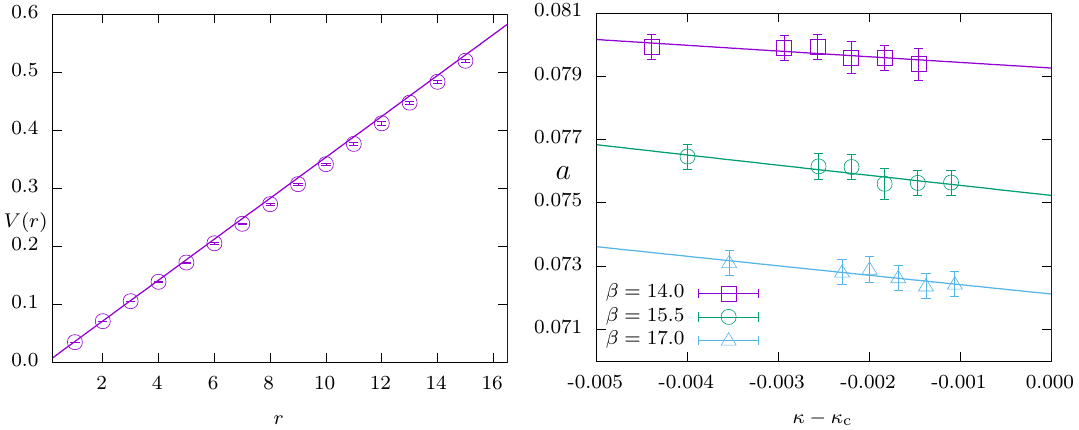
Figure 4. Left: static quark potential and (cid:12)t to (3.9) for (cid:12) = 17 : 0 and (cid:20) = 0 : 26655. Right: lattice spacing a for (cid:12) = 14 : 0 ; 15 : 5 and 17 : 0 as function of (cid:20) on a 64 (cid:2) 32